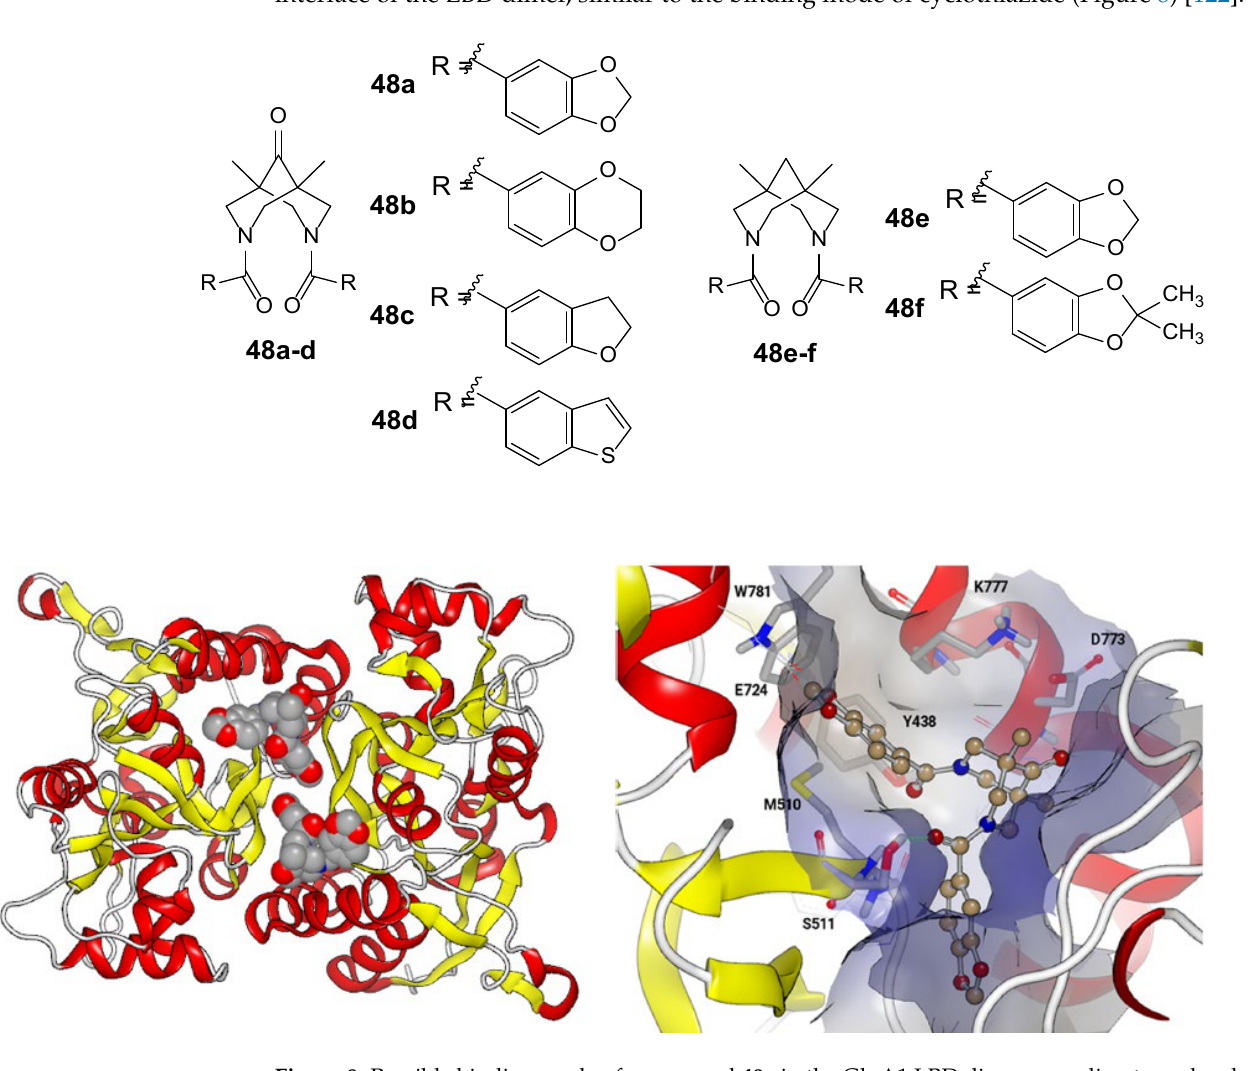
Figure 8. Possible binding mode of compound 48a in the GluA1 LBD dimer according to molecular docking data [122] (left: symmetrical binding sites of two modulator molecules at the interface of two subunits; right: detailed structure of the binding site). Adapted with permission from Ref. [122]. Copyright 2019, Springer Nature.